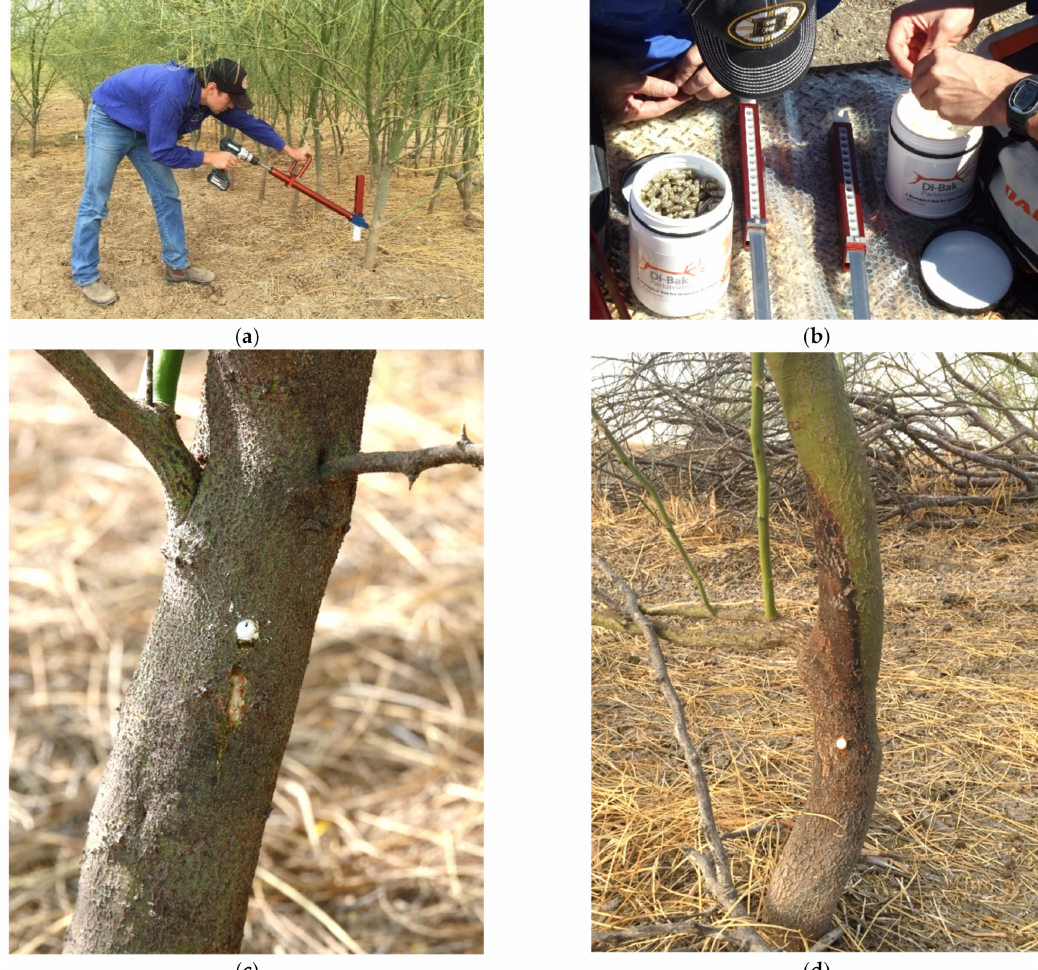
Figure 12. ( a ) Implanting a bioherbicide capsule into the lower stem of parkinsonia using a mechanical applicator; ( b ) loading the magazine with bioherbicide capsules and sealing plugs; ( c ) treated stem with sealing plug partially protruding from treatment hole; ( d ) parkinsonia stem six months after treatment showing a visible stem lesion in proximity to the treatment